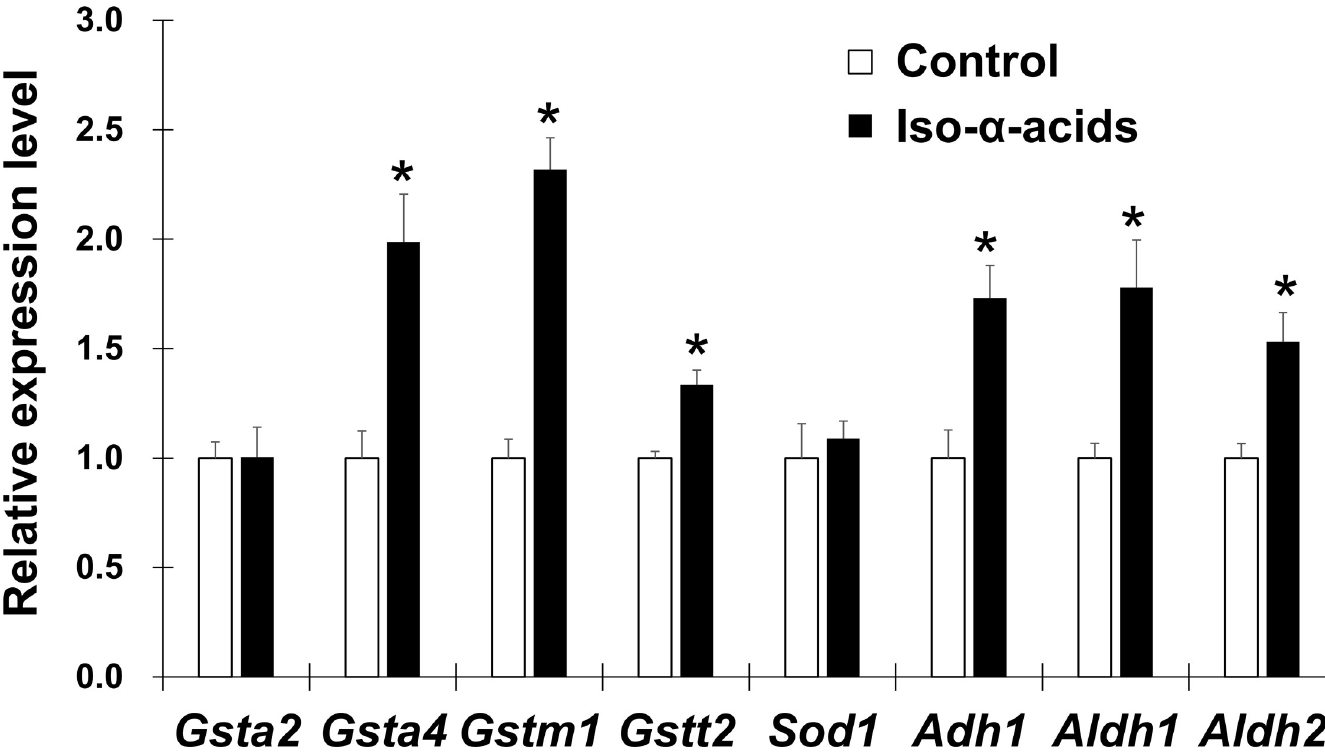
Fig 2. The effect of iso- α -acids on mRNA expression of genes related to the glutathione metabolic process, oxidative stress response and aldehyde metabolism in the liver. Mice fed the control diet or the iso- α -acids diet for a week were treated with acetaldehyde (200 mg/kg, i.p.) for 5 hours. mRNA levels were examined by quantitative RT-PCR and normalized to β -actin mRNA expression. The relative expression levels of genes were calculated as the ratio of levels in the iso- α -acids group relative to those in the control group. Data are shown as the mean ± S.E.M ( n = 5). � p < 0.05 (vs. the control group).